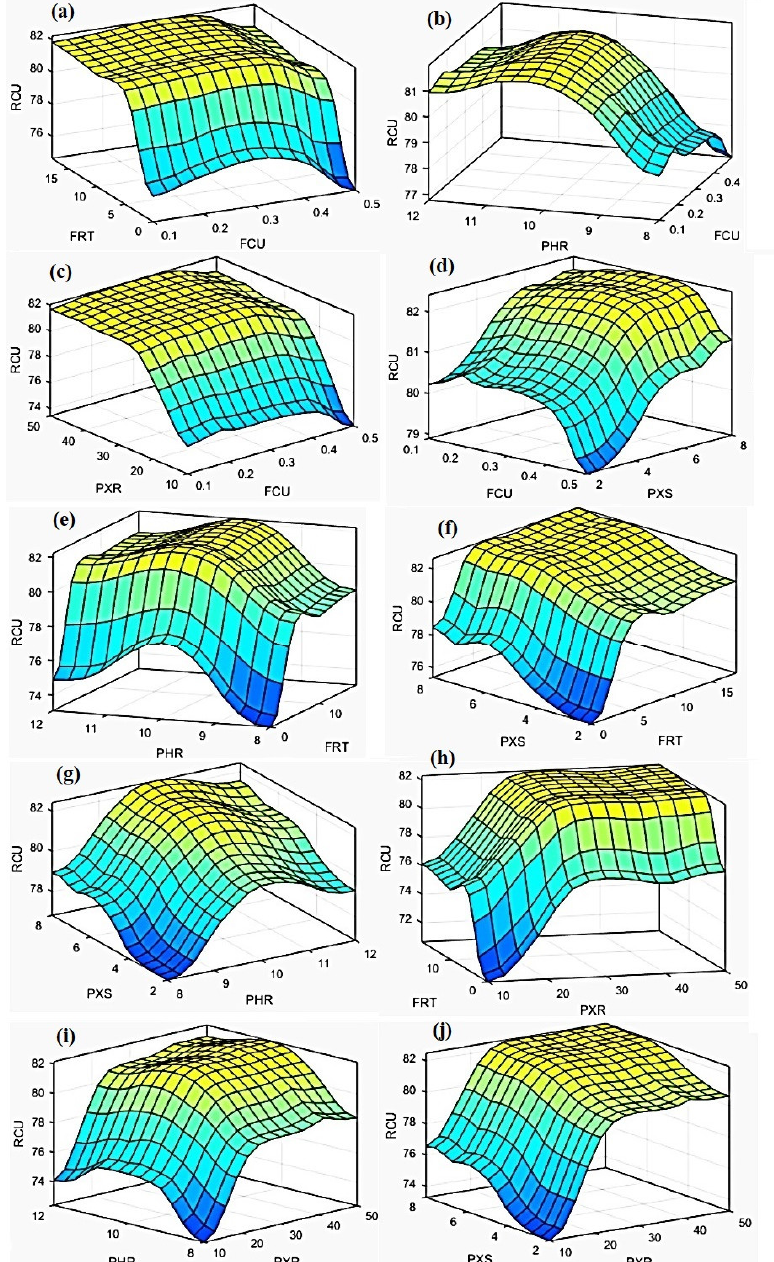
Figure 11. Resulting response surfaces of the PSM model—dependence of copper recovery (RCU) in final concentrate on input parameters. ( a ) copper content in the feed (FCU) and frother consumption (FRT); ( b ) copper content in the feed (FCU) and pH value of slurry at rougher flotation circuit (PHR); ( c ) copper content in the feed (FCU) and collector consumption at rougher flotation circuit (PXR); ( d ) copper content in the feed (FCU) and collector consumption at scavenger flotation ciruit (PXS); ( e ) frother consumption (FRT) and pH value of slurry at rougher flotation circuit (PHR); ( f ) frother consumption (FRT) and collector consumption at scavenger flotation ciruit (PXS); ( g ) pH value of slurry at rougher flotation circuit (PHR) and collector consumption at scavenger flotation ciruit (PXS); ( h ) frother consumption (FRT) and collector consumption at rougher flotation circuit (PXR); ( i ) pH value of slurry at rougher flotation circuit (PHR) and collector consumption at rougher flotation circuit (PXR); ( j ) collector consumption at scavenger flotation ciruit (PXS) and collector consumption at rougher flotation circuit